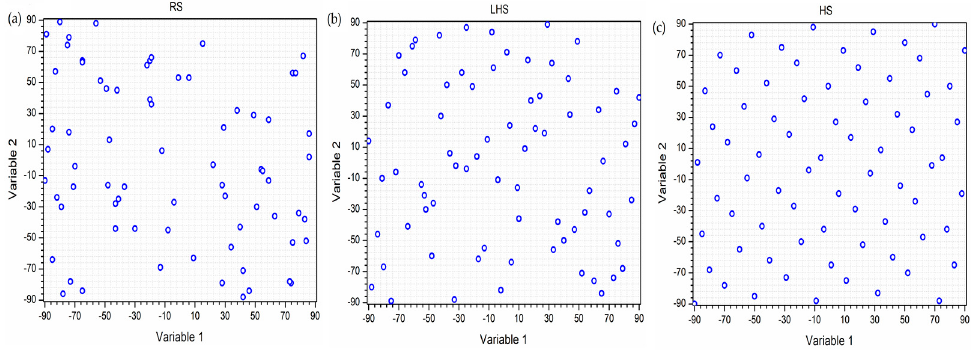
Figure 1. Distribution of two variables of LD-problem ( λ 1 ) in design space for ( a ) RS ( b ) LHS ( c ) HS.